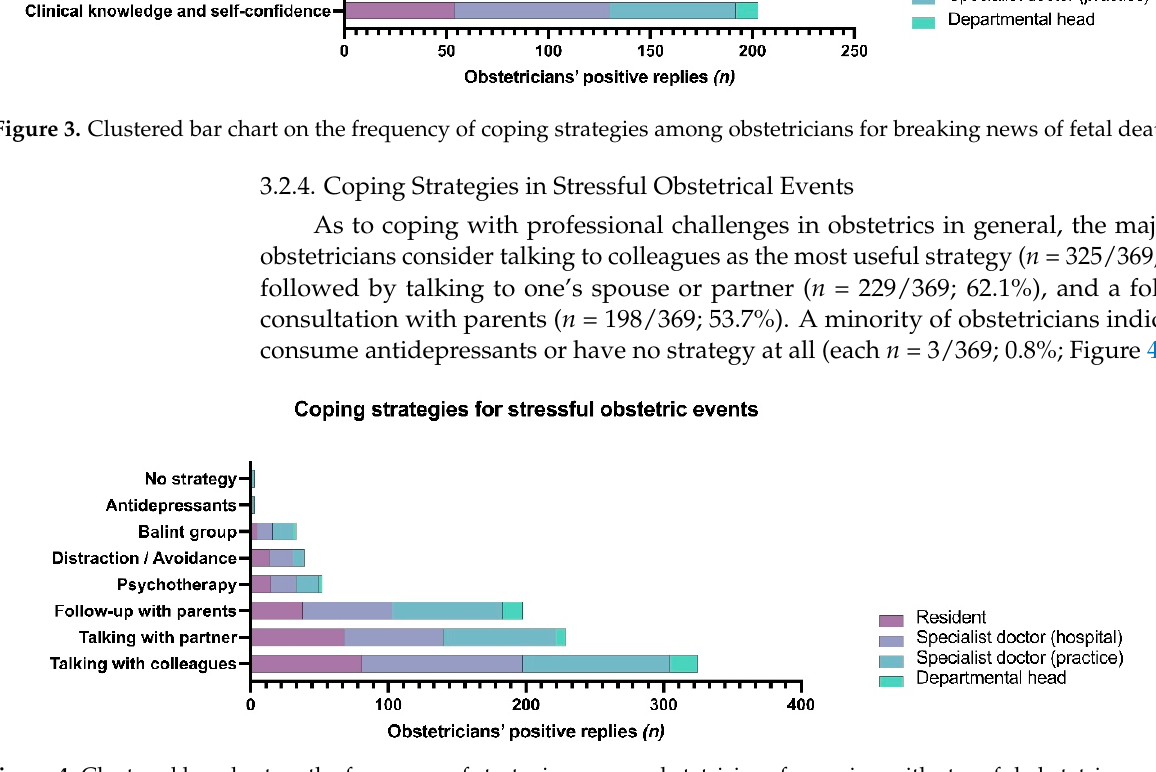
Figure 4. Clustered bar chart on the frequency of strategies among obstetricians for coping with stressful obstetric events.